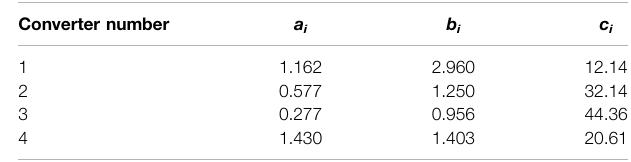
TABLE 2 | Parameters of AC microgrids. TABLE 3 | Converter loss coef fi